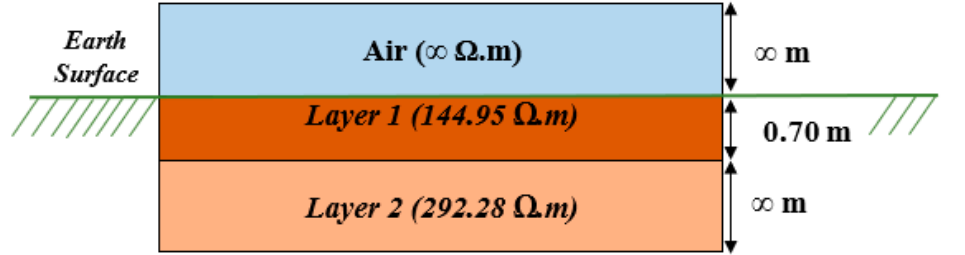
Figure 10. Tower T40 soil profile